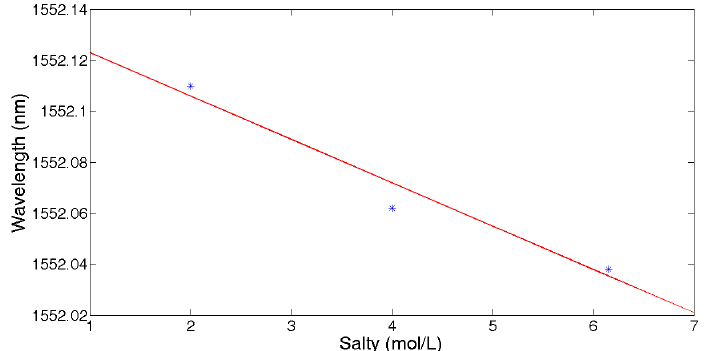
Figure 13. Central wavelength vs. salinity.